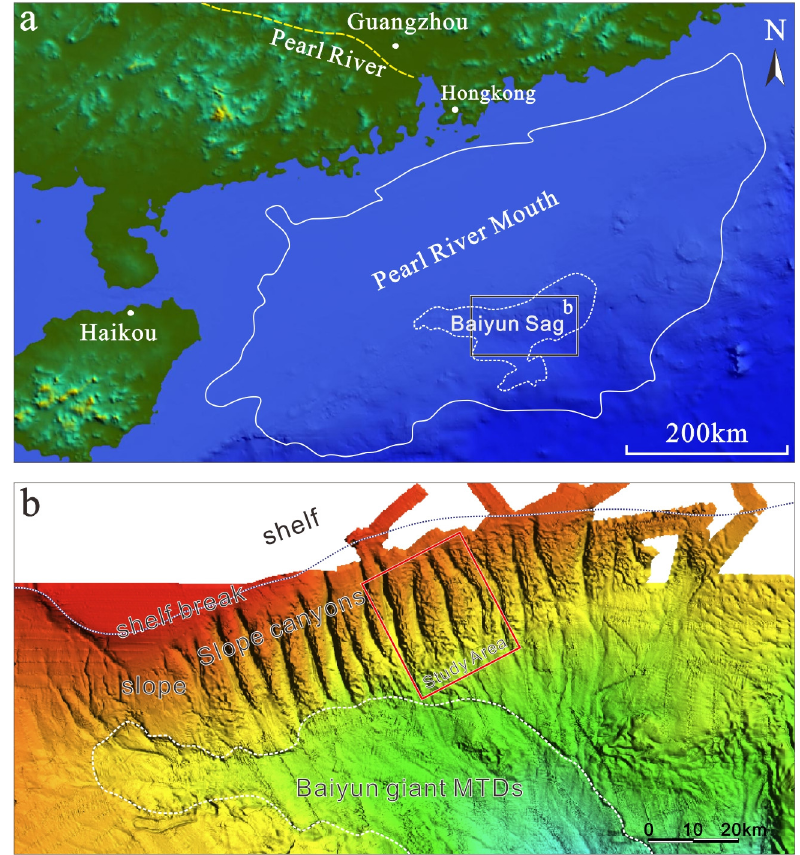
Figure 1. ( a ) Location of Pearl River Mouth Basin; ( b ) characteristics of seafloor morphology of shelf margin in Pearl River Mouth Basin, red rectangular represents the location of study area.